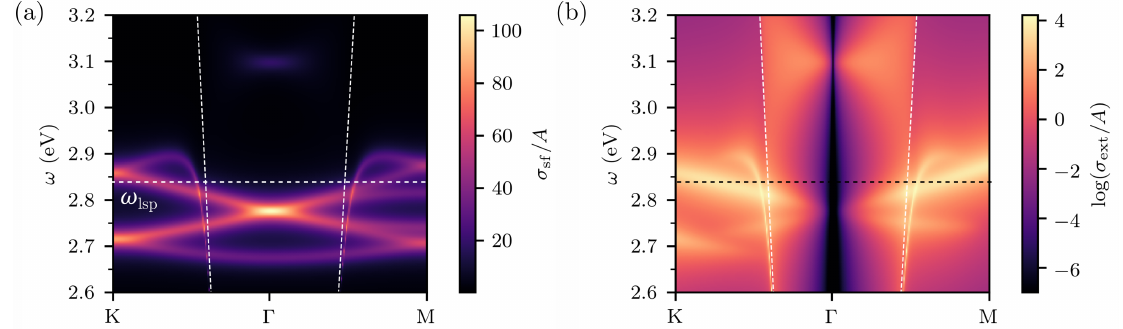
Figure A1. ( a ) Spectral function σ ext . There is a double Dirac cone degeneracy at Γ due to the folded Brillouin zone, ( b ) Extinction cross section σ ext .